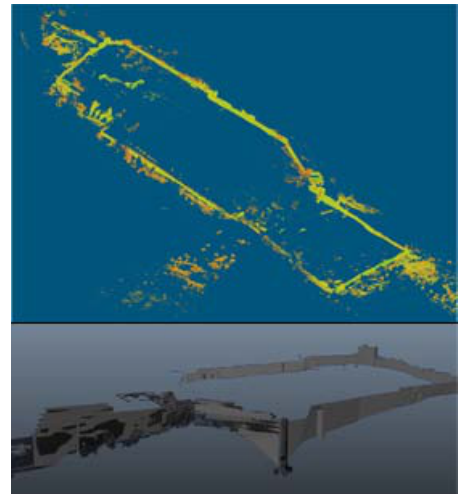
Figure 15. The point cloud of the surrounding wall and its 3D model.